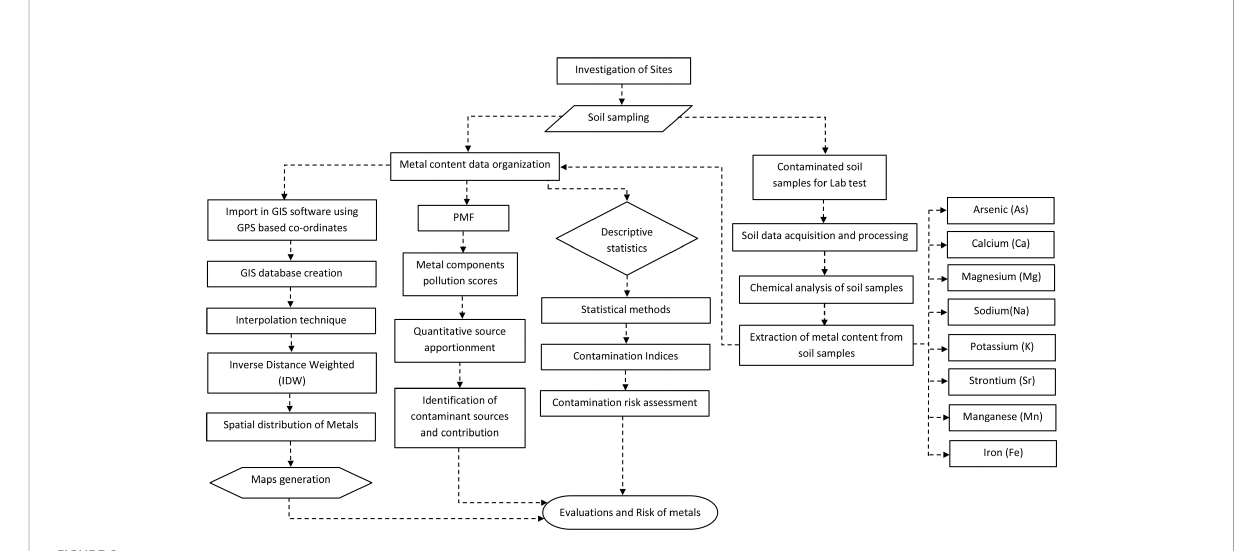
FIGURE 2 Flowchart illustrating the methodology of this